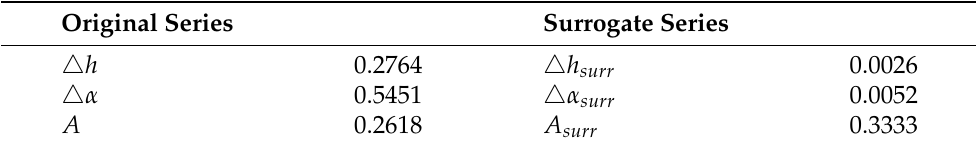
Figure 8. MF-DFA for the surrogate series of bitcoin 1 min returns. Table 3. Original series vs. surrogate series: degree of multifractality, width of multifractal spectrum, and asymmetry parameter.